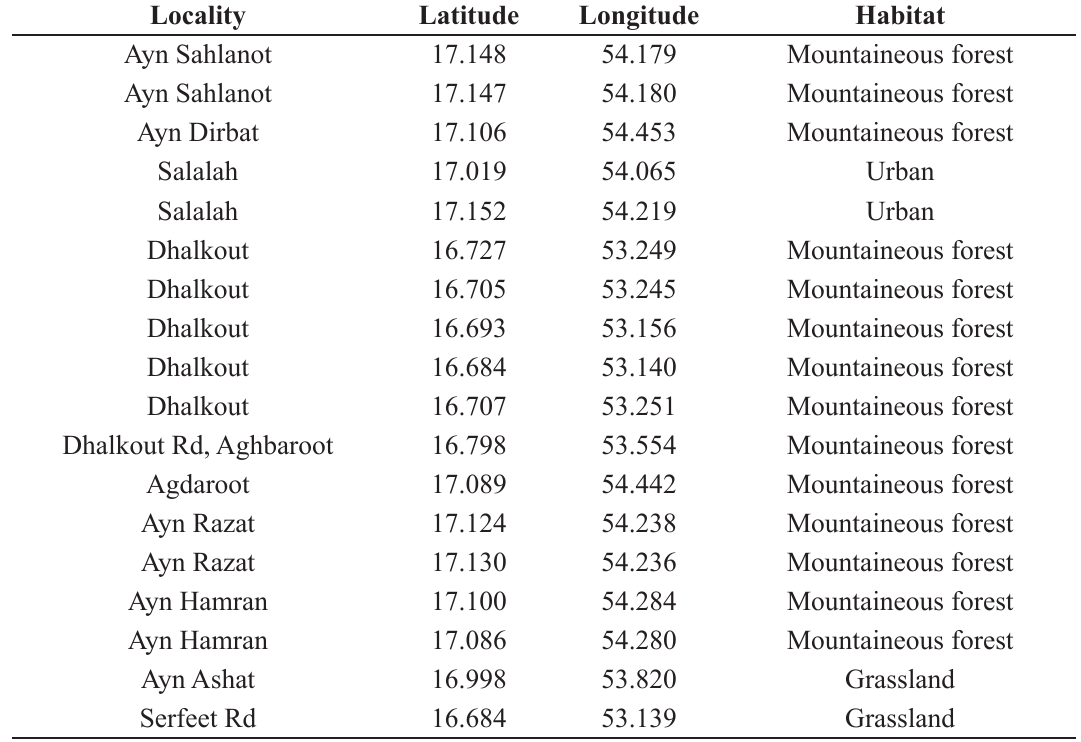
Table 1. The locations and GIS coordinates of sites from which ant specimens are collected in the Dhofar